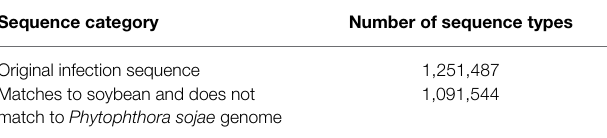
TABLE 2 | Data volume statistics before and after map.